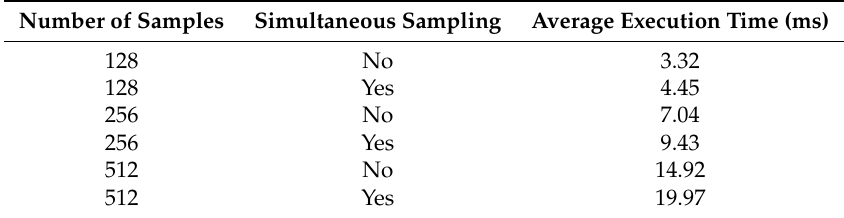
Table 5. Fast Fourier Transform execution